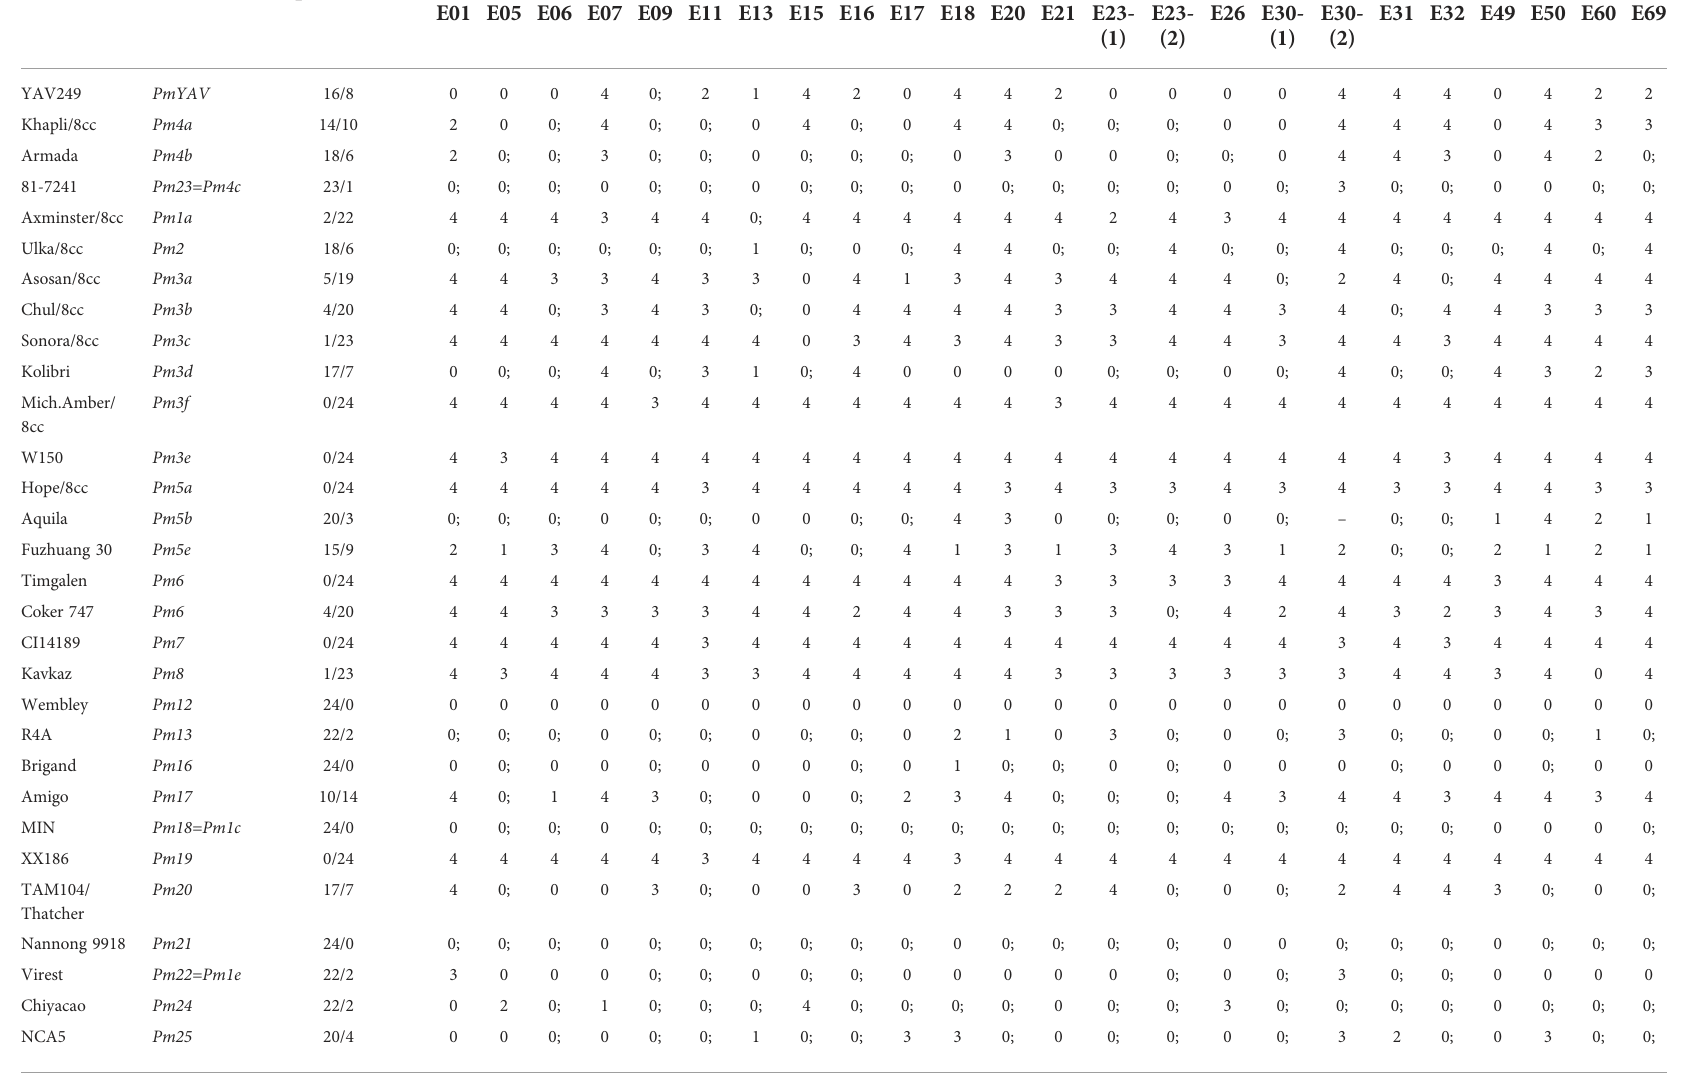
TABLE 1 Response spectra of YAV249 and wheat accessions with known powdery mildew ( Pm ) resistance genes to 24 different Blumeria graminis f. sp. tritici ( Bgt ) isolates at the seedling stage. Cultivars/